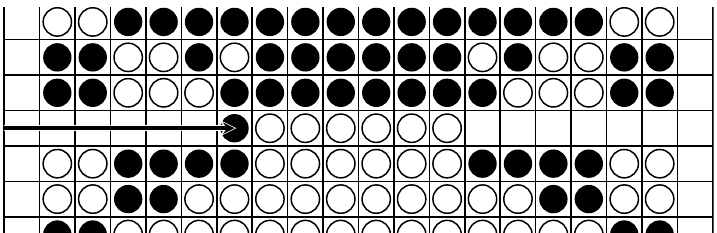
Figure 93. BLACK